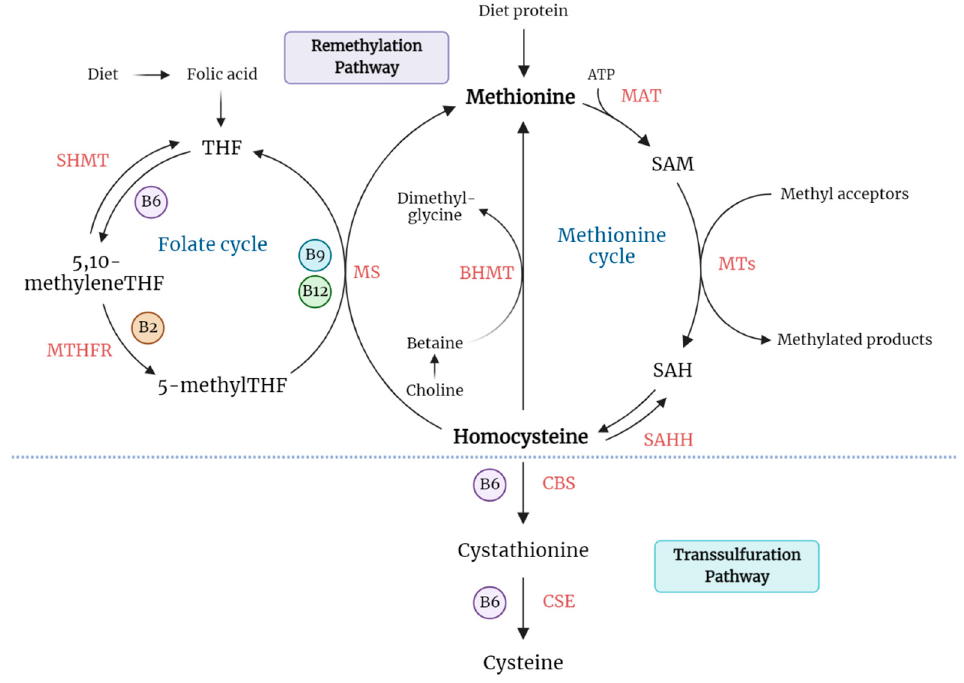
Figure 1. Schematic representation of homocysteine (Hcy) metabolism. Biosynthesis of Hcy occurs through the transmethylation of methionine via three sequential steps. Methionine is the only known source of Hcy and is acquired from diet protein. Metabolism of Hcy is at the intersection of two alternative pathways: it may be re-methylated back to methionine via folate-dependent/independent remethylation pathway or irreversibly degraded to cysteine via transsulfuration pathway. These pathways require vitamin-derived cofactors, including pyridoxine (vitamin B6), folate (vitamin B9), cobalamin (vitamin B12), and riboflavin (vitamin B2). Abbreviations; BHMT, betaine-homocysteine S-methyltransferase; CBS, cystathionine β -synthase; CSE, cystathionine γ -lyase; MAT, methionine adenosyltransferase; MS, methionine synthase; MT, methyltransferase; MTHFR, 5,10-methylenetetrahydrofolate reductase; SAH, S-adenosylhomocysteine; SAHH, S-adenosylhomocysteine hydrolase; SAM, S-adenosylmethionine; SHMT, serine hydroxymethyltransferase; THF, tetrahydrofolate.